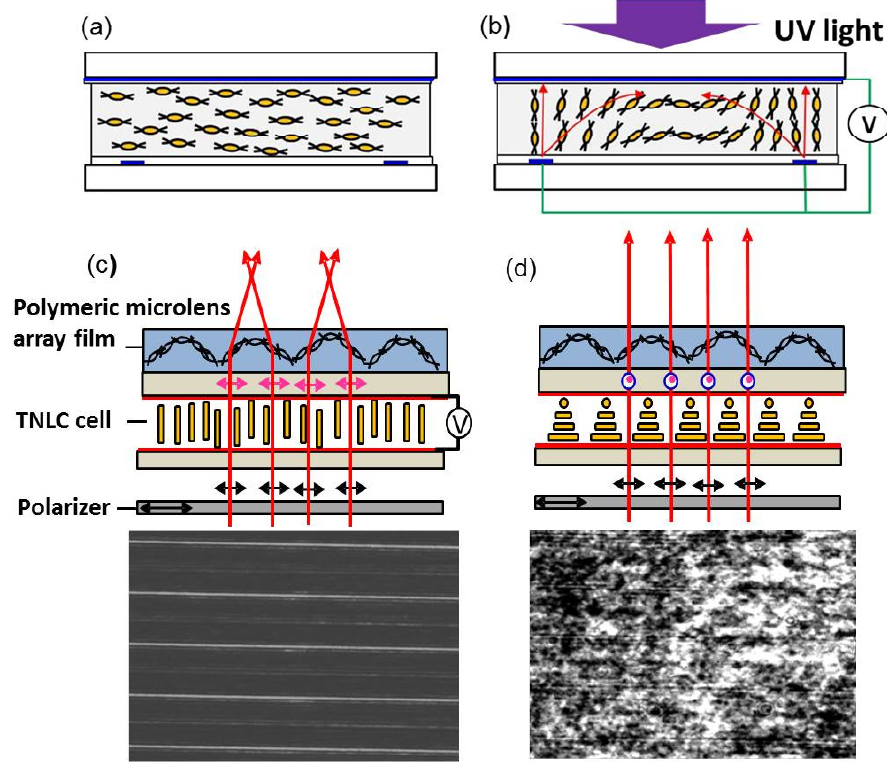
Figure 7. Operation principle of a switchable 2D/3D display with a TN broadband polarization rotator (middle) and a polymeric microlens array (top): ( a ) voltage-off, ( b ) voltage-on, ( c ) focusing state and ( d ) non-focusing